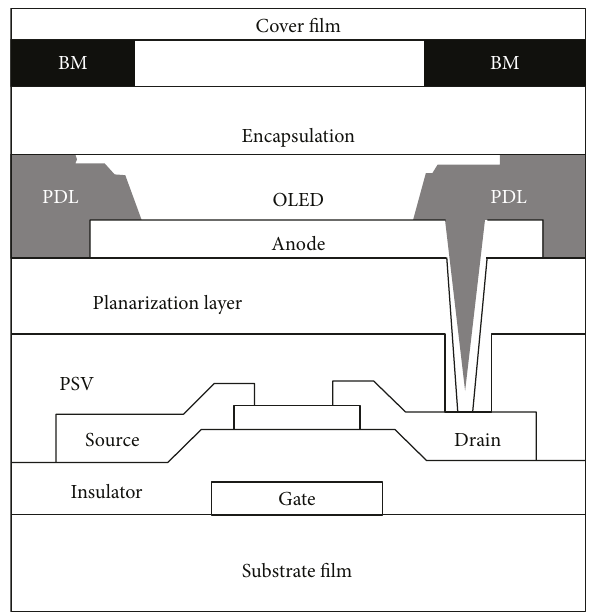
Figure 1: Typical cross-sectional view of an OLED